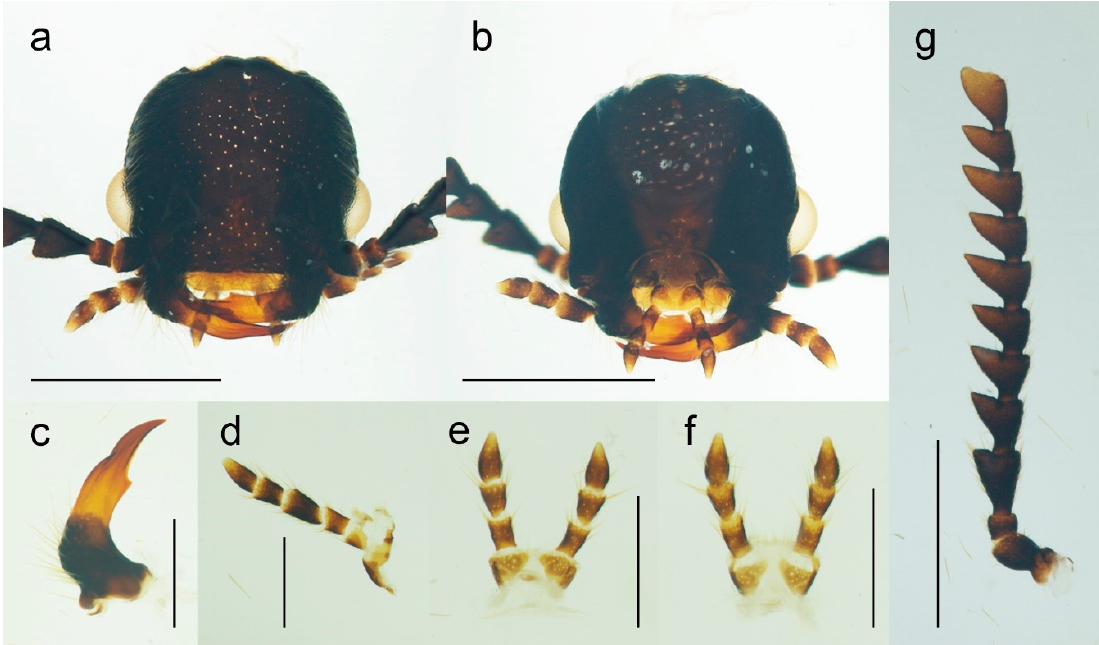
Figure 3. Malacogaster passerinii Bassi, 1834 from Sardinia, Italy, male (PCRK), details of morphology. ( a ) Head, dorsal view; ( b ) head, ventral view; ( c ) left mandible; ( d ) maxilla; ( e ) labium, ventral view; ( f ) labium, dorsal view; ( g ) right antenna. Scale bars = ( a , b , g ) 1.0 mm; ( c – f ) 0.5 mm.